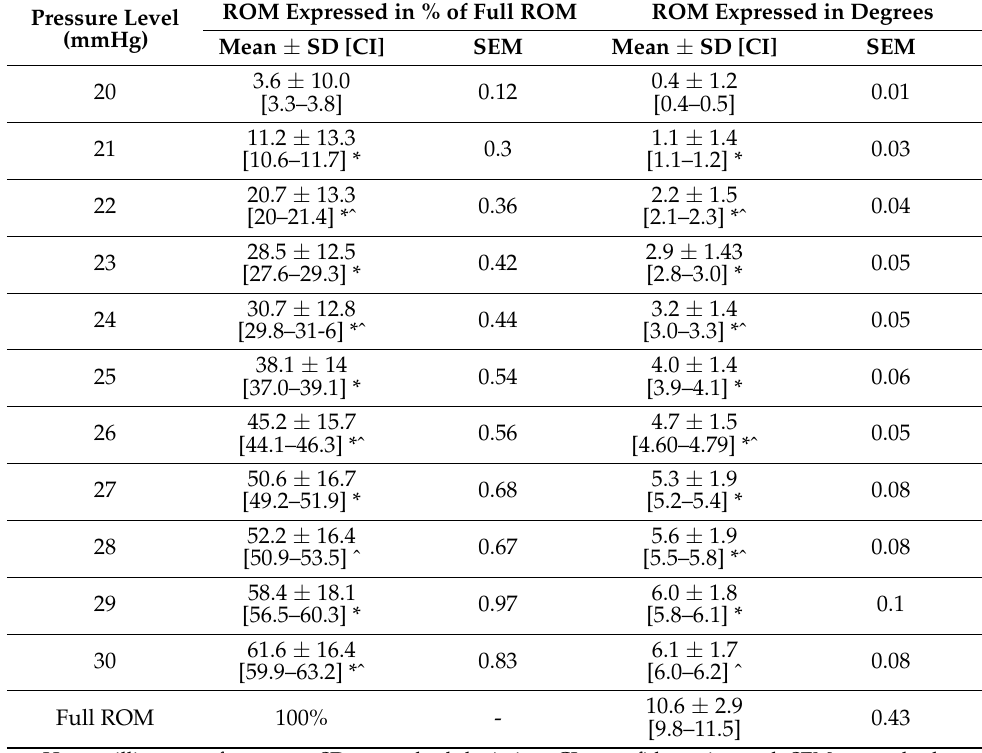
Table 2. Descriptive data for craniocervical ROM associated with 1 mmHg levels of